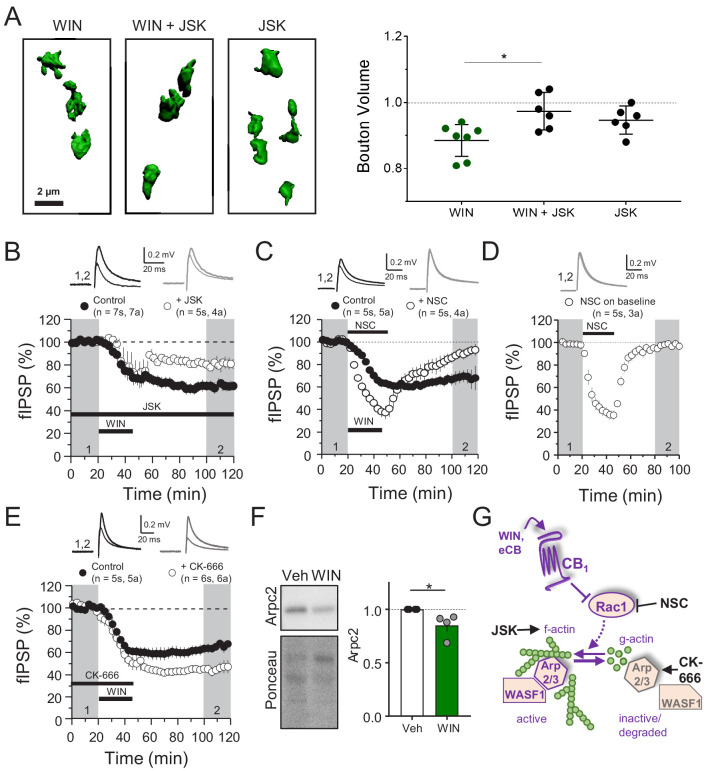
CB1-iLTD involves actin remodeling via Rac1 and Arp2/3.(A) Left, representative single boutons reconstructed in 3D. Right, quantification of mean bouton volume per slice normalized to control. Activation of CB1 receptors with WIN for 25 min led to decreased bouton volume that was blocked by treatment with jasplakinolide (JSK, 250 nM). Summary data expressed as normalized change from Control. WIN + 1 hr: 0.89 ± 0.02 vs. WIN + JSK: 0.97 ± 0.02 vs. JSK: 0.95 ± 0.02 (Mean ± S.E.M.); F[2,16]=5.56, p=0.015, one-way ANOVA with post-hoc Tukey test for multiple comparisons. WIN vs. WIN + JSK: CI[−0.16,–0.018], p=0.014. n = number of slices (three images/slice, 1–2 slices/rat, six rats/condition). For all structural plasticity figures, data are presented as points representing mean bouton volume per slice with a horizontal black line representing the mean per condition and the vertical line indicating 95% confidence interval (CI). 95% CIs are given as CI[lower CI, upper CI]. p-Values are exact. Refer to Figure 3—figure supplement 1A for distribution of individual bouton values. (B) CB1-iLTD is impaired by bath application of actin-stabilizing drug, jasplakinolide (JSK, 250 nM). Extracellular field inhibitory postsynaptic potential (fIPSP) were recorded in the CA1 pyramidal cell body layer in acute hippocampal slices. Control: 61.4 ± 4% vs. JSK: 80.5 ± 4%; p<0.05, unpaired t-test. Unless otherwise specified, n = number of slices (s), number of animals (a). (C) CB1-iLTD was blocked by acute bath application of the Rac1 inhibitor NSC (30 µM). Control: 68.8 ± 6% vs. NSC23766: 89.7 ± 4%; p<0.05, unpaired t-test. (D) NSC (30 µM) bath application reversibly depressed basal transmission. NSC: 98 ± 2%, one sample t-test, p>0.05. (E) CB1-iLTD is enhanced by acute bath application of the Arp2/3 inhibitor CK-666 (100 µM). Control: 63.8 ± 4% vs. CK-666: 45.2 ± 4%, p>0.05, unpaired t-test. (F) Left, representative Western blots of staining for Arpc2 and Ponceau loading control in vehicle or WIN-treated hippocampal cultures. Right, Arpc2 was downregulated in hippocampal neuron cultures after CB1 activation with WIN (5 µM, 25 min). Arpc2 (Fold of Veh): 0.851 ± 0.06, U = 16, Z = 2.31, * indicates p<0.05, Mann-Whitney. Dots represent individual values for four independent experiments. Data in the bar plot represent mean ± S.E.M. (G) Proposed model of CB1-iLTD pathway and mechanism of action of pharmacological reagents. CB1 activation triggers protein synthesis (not shown) and leads to inhibition of Rac1 which causes disassembly of the Arp2/3-WASF1 complex. Arp2/3 is degraded leading to actin remodeling. Actin dynamics are required for CB1-iLTD. NSC inhibits Rac1-GEF interaction. CK-666 stabilizes the inactive conformation of Arp2/3, preventing it from binding actin filaments. JSK stabilizes actin filaments and promotes polymerization.